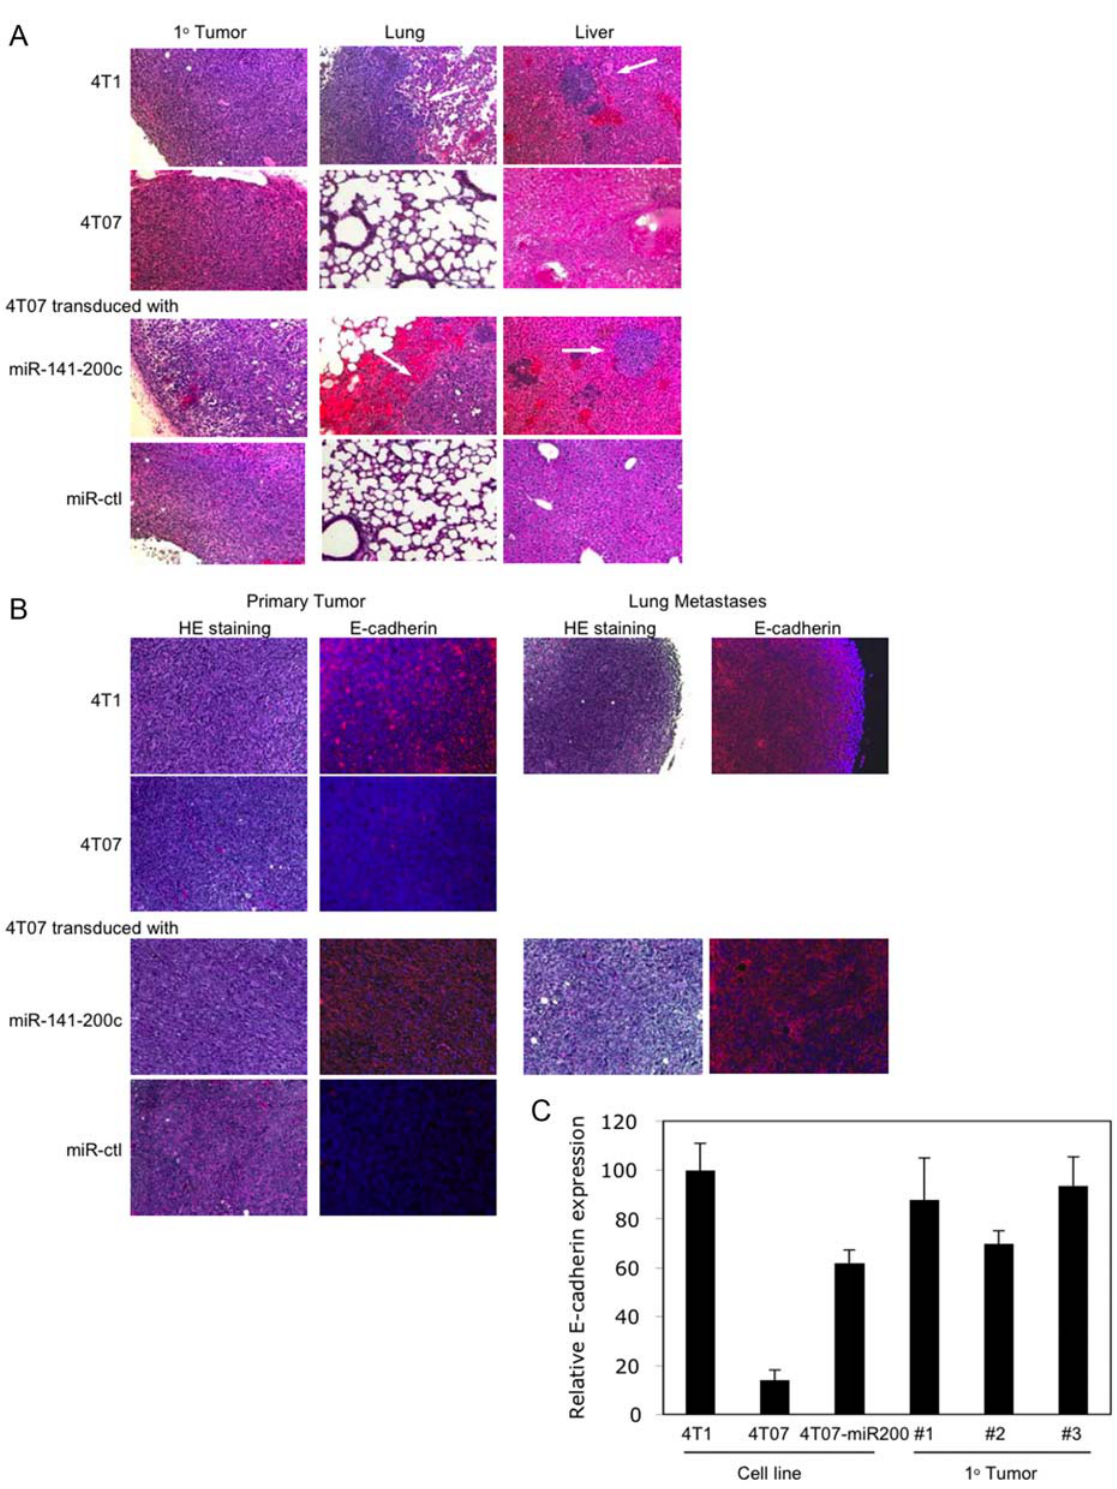
Figure 8. Primary tumors and metastases of 4TO7 cells stably expressing the miR-141-200c cluster express E-cadherin. (A) Representative primary mammary tumors and lung and liver tissue sections stained with hematoxylin and eosin from mice implanted with parental 4T1 and 4TO7 cells or 4TO7 cells stably-expressing miR-141-200c or control vector. 4TO7 cells and 4TO7 cells expressing the control miRNA (miR-ctl) did not form metastases. (B) Primary tumors and lung metastases formed from 4T1 cells and 4TO7 cells transduced with miR-141-200c retrovirus continue to express E-cadherin, while primary tumors from 4TO7 parental cells or 4TO7 cells infected with a control retrovirus remain E-cadherin-. (C) Primary tumors from 3 mice implanted with 4TO7 cells stably expressing miR-141-200c showed high levels of E-cadherin mRNA, analyzed by qRT-PCR and normalized to Gapdh, compared to parental 4TO7 cells. Mean and standard deviation from triplicate samples of each cell line or tumor are shown.